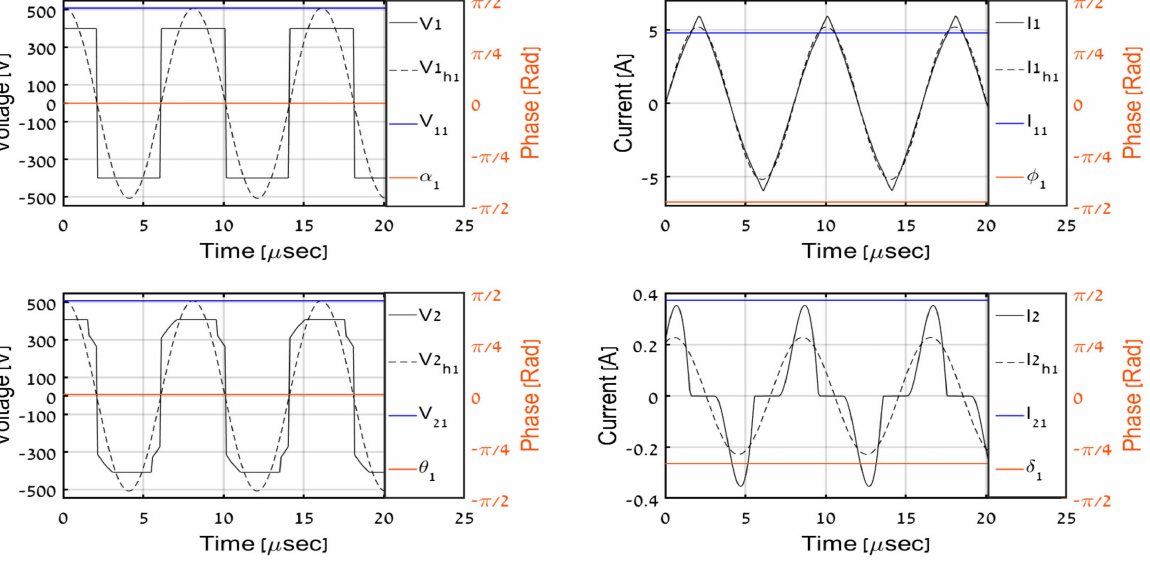
Figure 13. Simulation results, P O = 50 W.